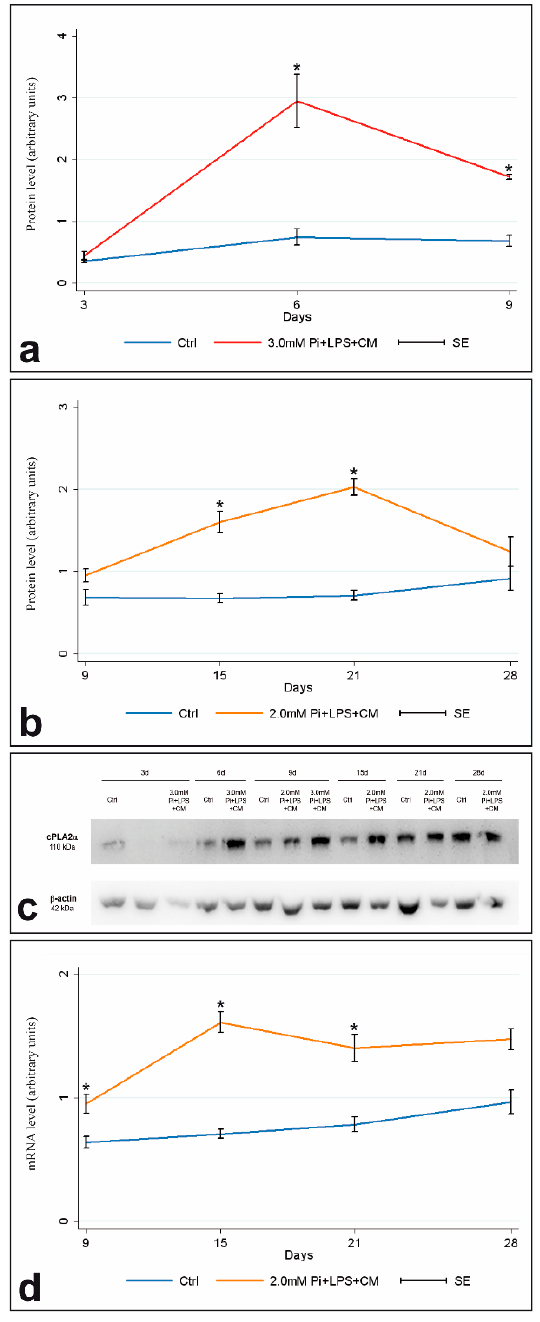
Figure 1. Quantification of cPLA2 α in cultured AVICs. ( a ) Western blotting quantification of cPLA2 α in 3 ‐ to 9 ‐ day ‐ long control and metastatic calcification ‐ like cultures. Protein levels are calculated as cPLA2 α / β‐ actin, with the control being set to 1. Data are shown as mean ± SE. Statistically significant values are indicated with asterisks ( p < 0.05). ( b ) Western blotting quantification of cPLA2 α in 9 ‐ to 28 ‐ day ‐ long control and severe dystrophic calcification ‐ like cultures. Protein levels are calculated as cPLA2 α / β‐ actin, with the control being set to 1. Data are shown as mean ± SE. Statistically significant values are indicated with asterisks ( p < 0.05). ( c ) Representative Western blotting obtained